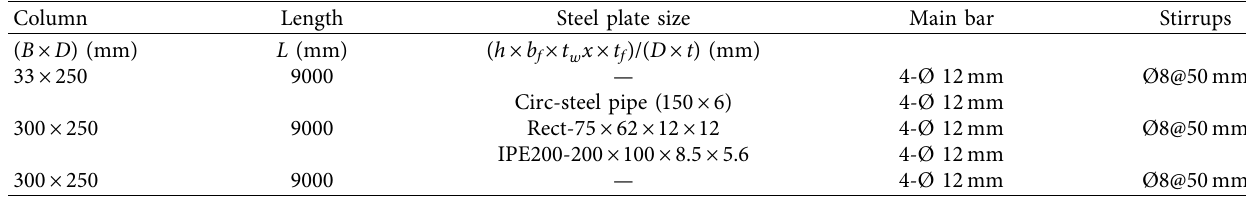
Figure 2: Stress-strain curves for uniaxial (a) unconfned concrete compression and (b) confned concrete Table 3: Geometrical properties of column specimens.